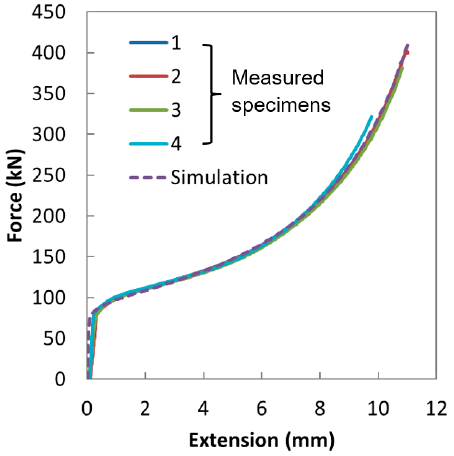
Figure 17. Comparison of compression test curves.